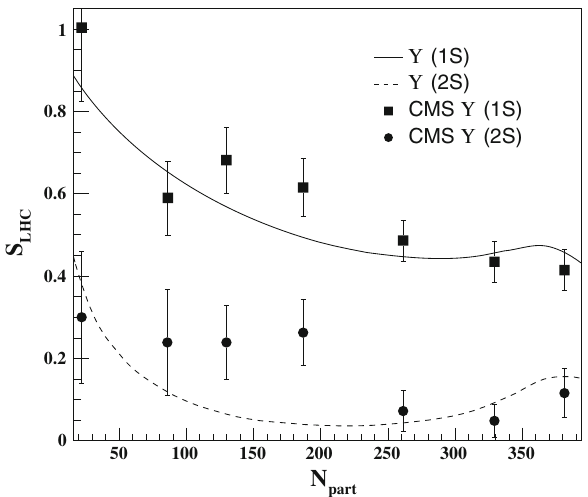
Fig. 24 Variation of survival probability (S) of [ ψ (cid:8) / J /ψ ] / [ ψ (cid:8) / J /ψ ] √ PbPb pp with respect to N part at center of s NN = 2 . 76 TeV. Experimental Data are taken from mass energy Refs. [53,54]